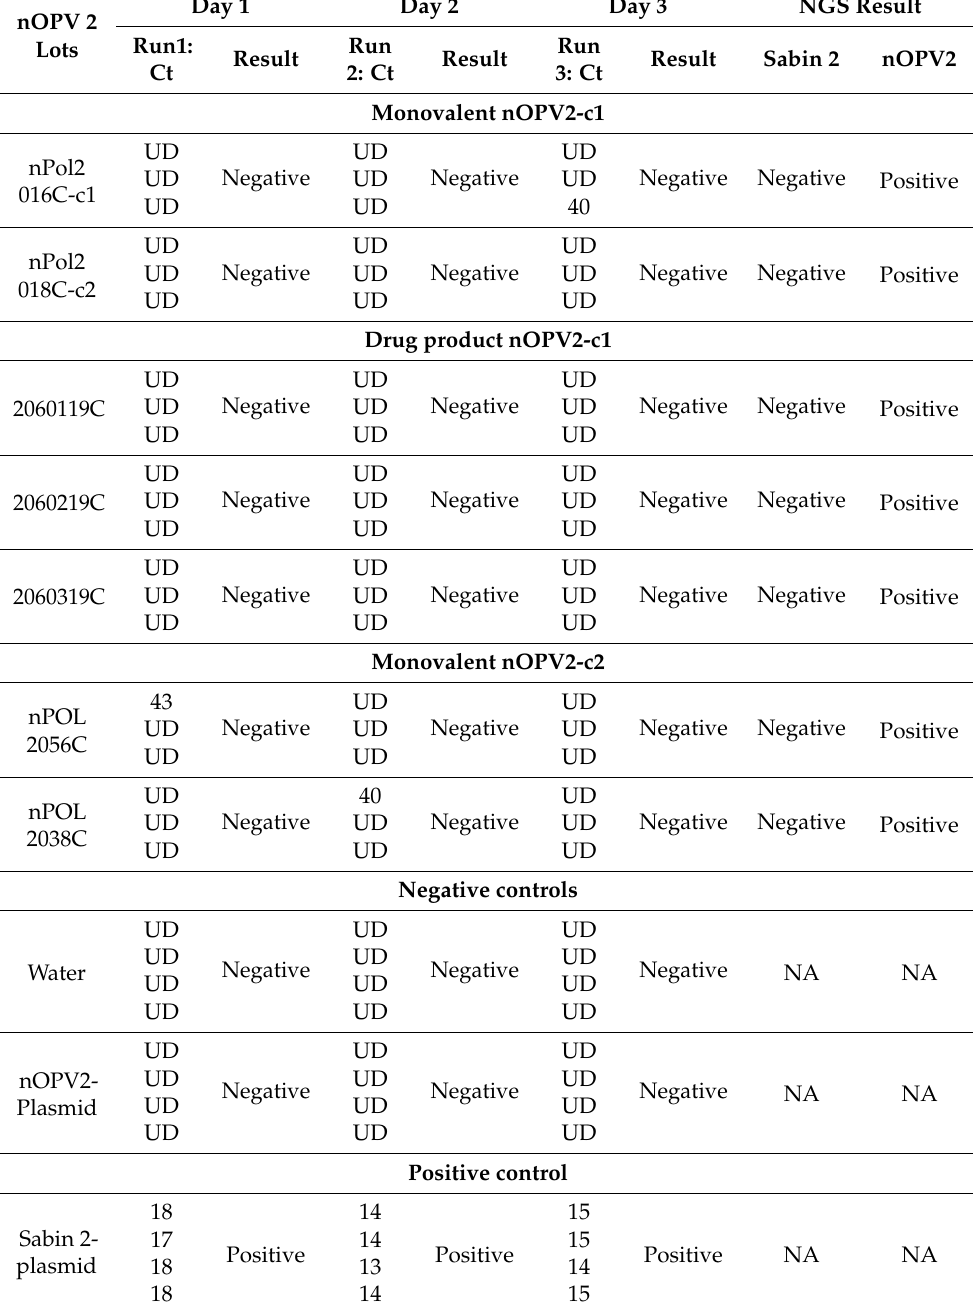
Table 5. Analysis of nOPV2 lots by qosRT-PCR assay for detection Sabin 2